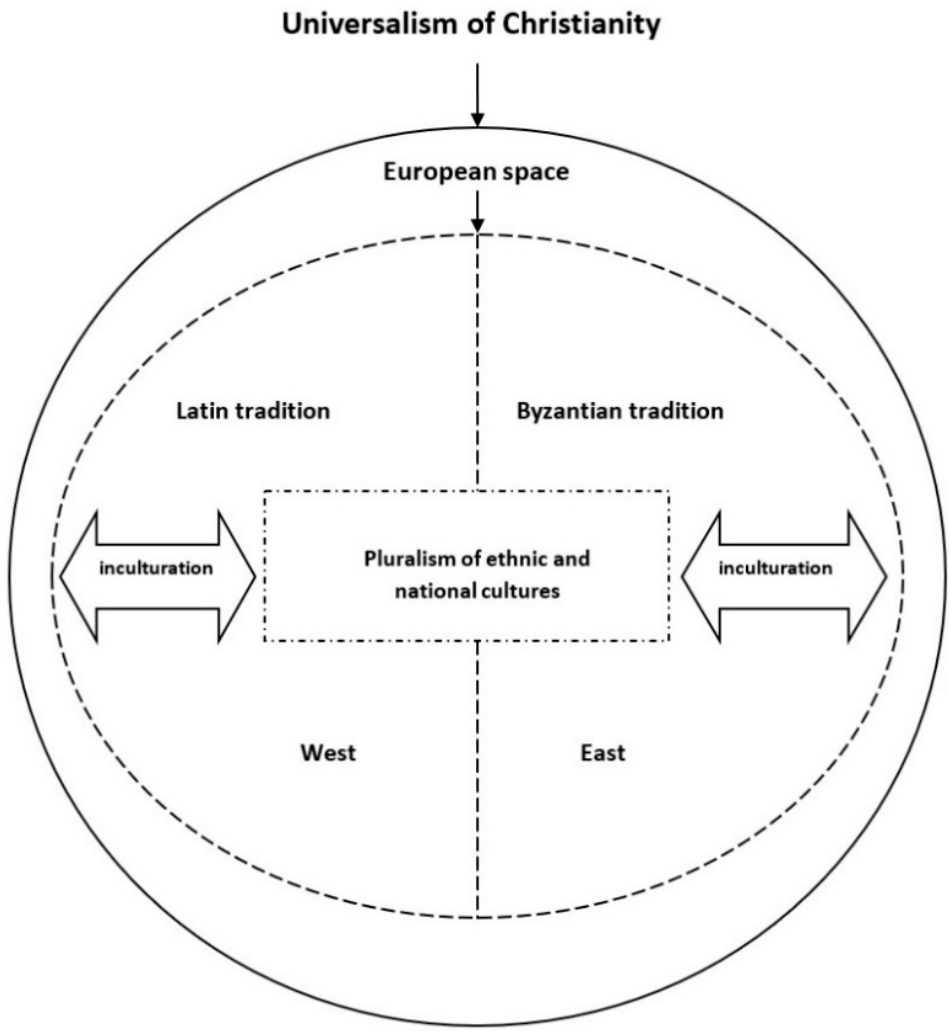
Figure 1. Model of European unity in the thought of Karol Wojtyła, i.e., John Paul II. Source: own study.